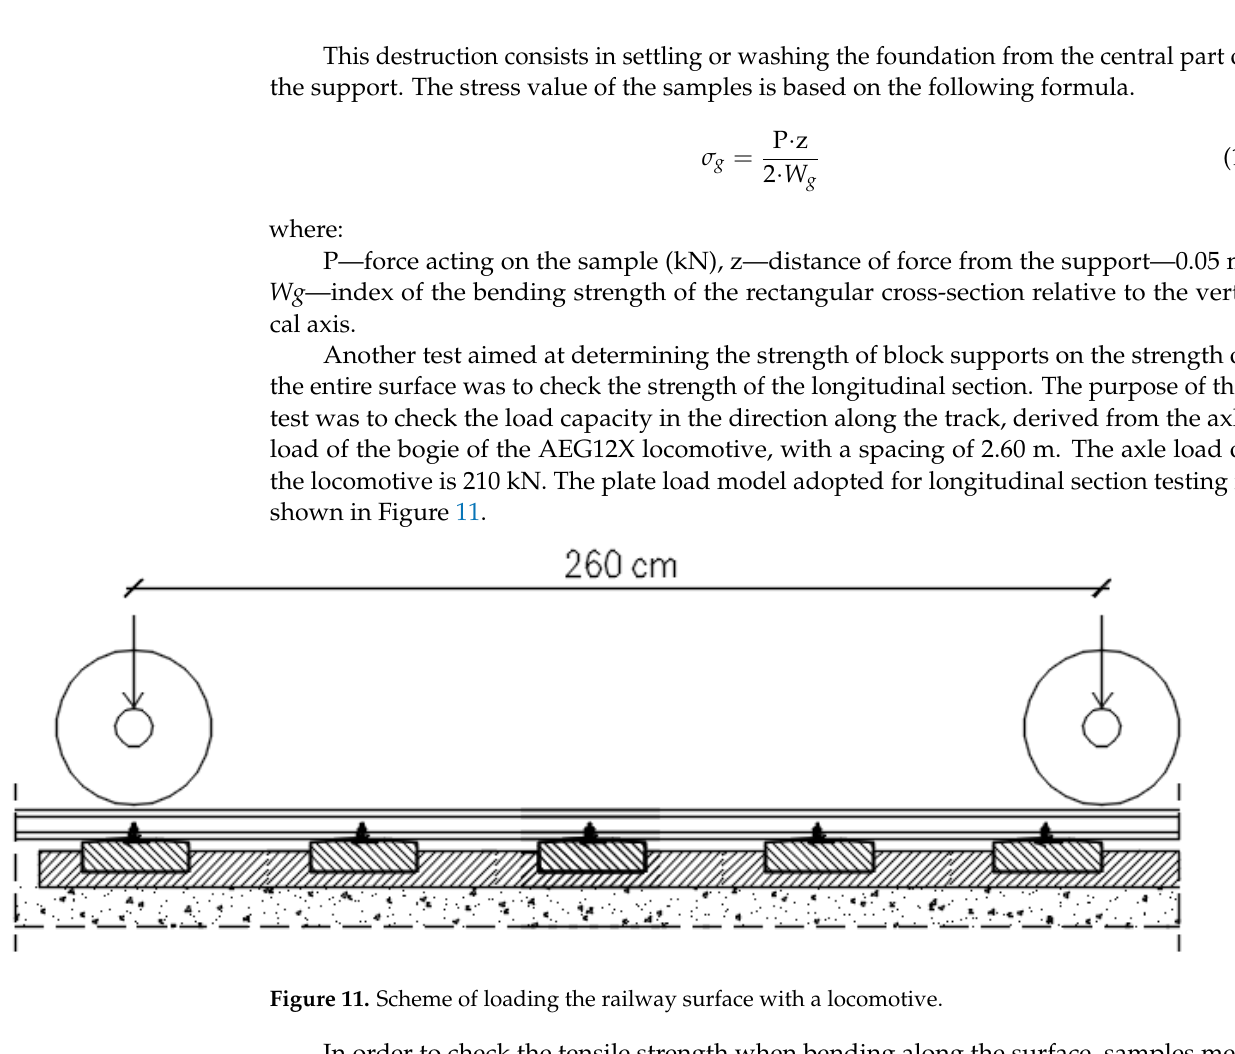
Figure 1 2. Diagram of the test sample—dimensions are expressed in cm.